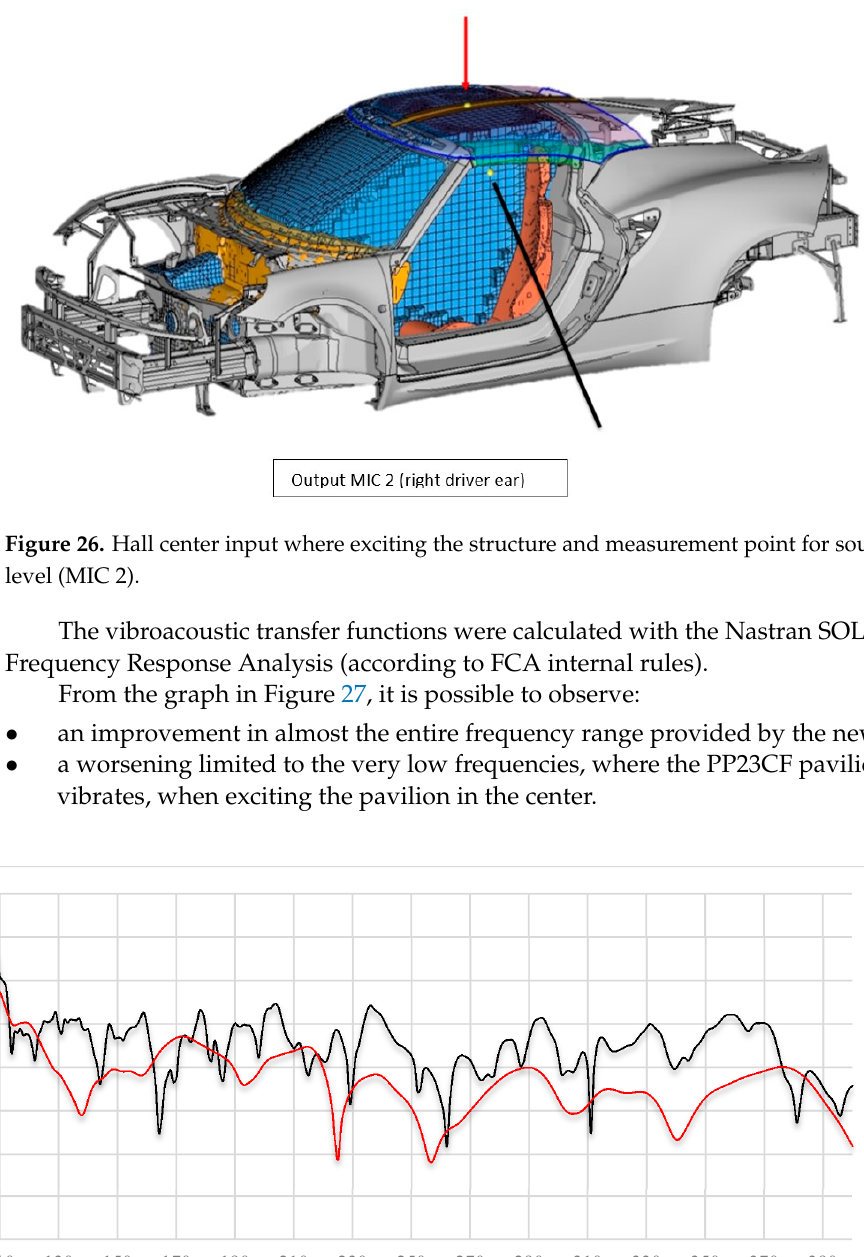
Figure 25. Positioning of listening point inside passenger compartment.